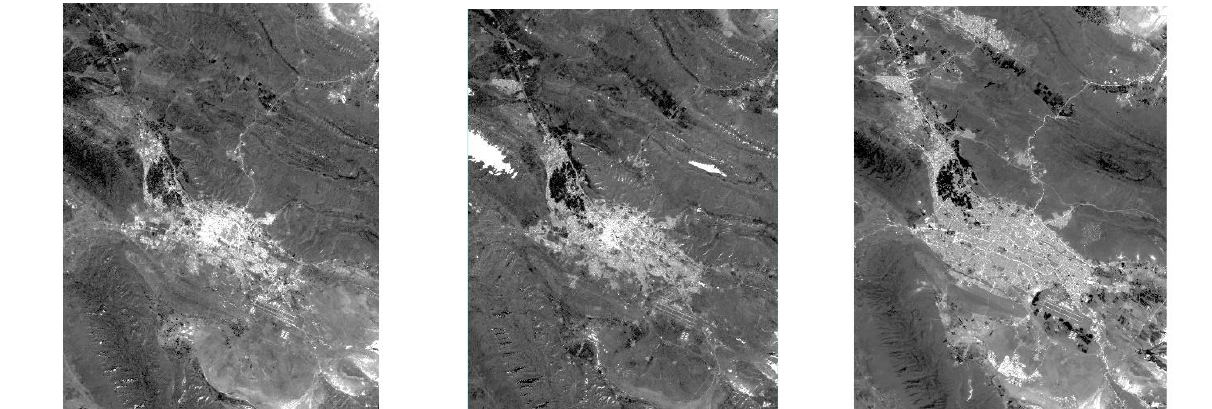
Figure 1. Normalized Difference Build-up Index (NDBI) for Shiraz city in 1990 (left picture, Landsat 5 image), 2000 (middle picture, Landsat 7 image) and 2018 (right picture, Landsat 8 OLI